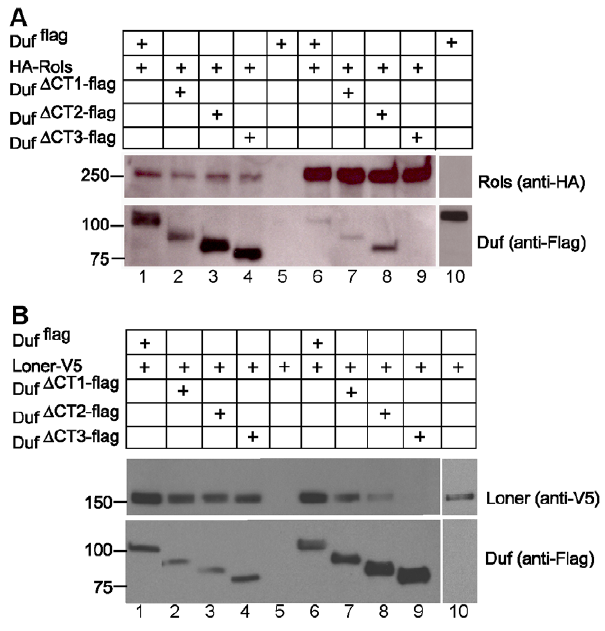
Figure 3. Duf intracellular domain between amino acid 687 and 830 interacts with Rols and Loner. Co immunoprecipitations (Co-IP) were performed on S2 cells co transfected with wild type Duf flag , Duf D CT1-flag , Duf D CT2-flag , Duf D CT3-flag and HA-Rols or Loner-V5. Input (lanes 1–4 and 10) and Co-IP (lanes 5–9). (A) Rols-Duf complexes were pulled down with anti-HA and probed with anti-Flag to detect Duf and anti-HA to detect Rols. Wild type Duf flag , Duf D CT1-flag and Duf D CT2-flag interacts with Rols (lanes 6,7 and 8) while Duf D CT3-flag fails to interact with Rols (lane 9). Cells transfected with Duf flag alone and immunoprecipitated with anti-HA were used as a negative control (input-lane 10, co-IP-lane 5). The input in lane 3 is , 5 fold higher than that in lane 1. Correspondingly the IP in lane 8 is , 5 fold higher than that in lane 6. Quantified using Image J. (B) Loner-Duf complexes were pulled down with anti-Flag and probed with anti-Flag to detect Duf and anti-V5 to detect Loner. Wild type Duf flag , Duf D CT1-flag and Duf D CT2-flag interacts with Loner (lanes 6,7 and 8) while Duf D CT3-flag fails to interact with Loner (lane 9). Cells transfected with Loner-V5 alone and immunoprecipitated with anti-Flag were used as a negative control (input-lane 10, co-IP-lane 5). DA1 nuclear number is similar to that shown by the expression of Duf D CT3-flag (Fig. 4G, Tables 1 and S1). But there is a greater percentage of hemisegments (5% v/s 2.5%) with 3 and 4 nuclei in embryos rescued with Duf D CT4-flag versus Duf D CT5-flag (Fig. 4H). Even at the terminal stages of fusion at late stage 15, duf, rst embryos rescued with Duf D CT5-flag have a maximum of 4 nuclei in their DA1 muscles while Duf D CT4-flag is able to rescue DA1